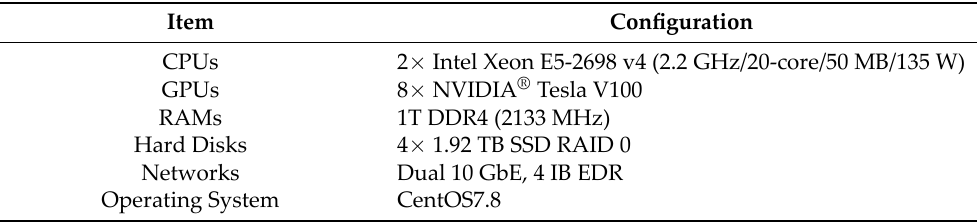
Table 3. The configuration of the NVIDIA deep learning server deploying the NEL model.